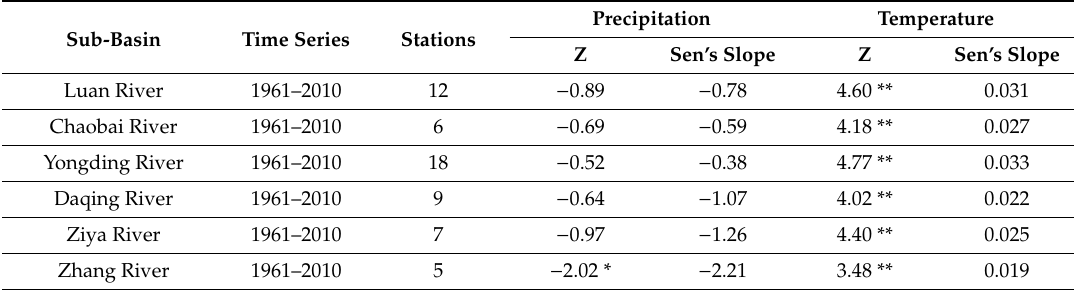
Table 1. Mann–Kendall (M–K) trends of precipitation and air temperature in upstream mountainous areas of the six sub-basins of the Haihe River